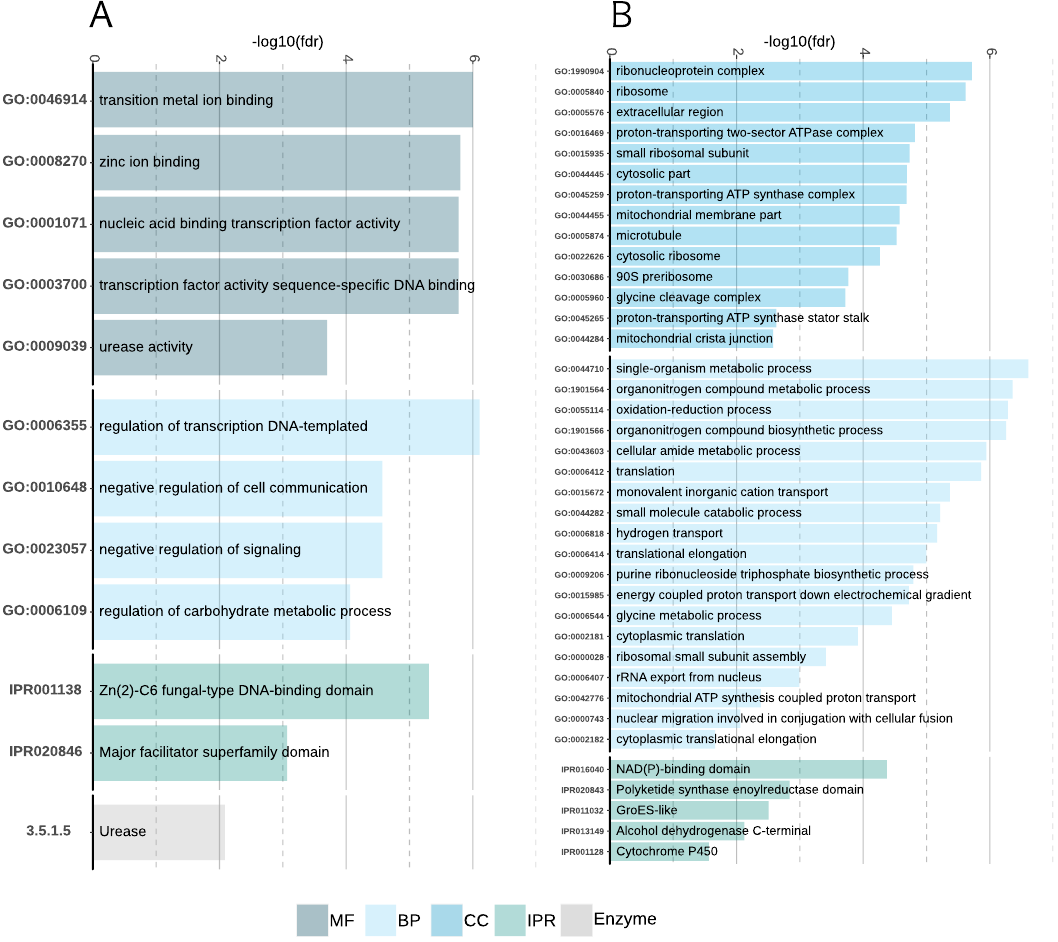
Figure 5. Bar plots showing overrepresented functional annotations in the set of regulated genes in A. sclerotialis . ( A ) Enriched functional terms in the set of downregulated genes. ( B ) Enriched functional terms in the set of upregulated